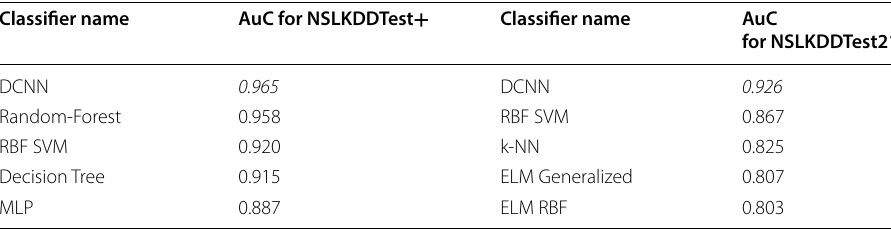
Table 5 Classifier performance results, reproduced from [62], classifier names are abbreviated as follows: Deep Convolutional Neural Network ( DCNN ), Radial Basis Function Support Vector Machine ( RBF SVM ), Multi-Layer Perceptron (MLP), Extreme Learning Machine ( ELM ), Radial Basis Function ( RBF ); NSLKDDTest partitions of the NSLKDD dataset [71] for evaluating trained